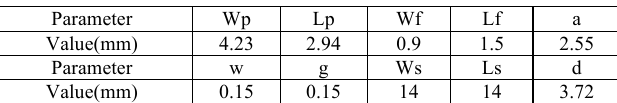
FIGURE 1. The proposed MIMO antenna development stages: (a) patch antenna, (b) patch antenna with CSRR, and (c) final MIMO geometry. T ABLE I. The single and proposed MIMO antenna parameters and their values (unit: mm)